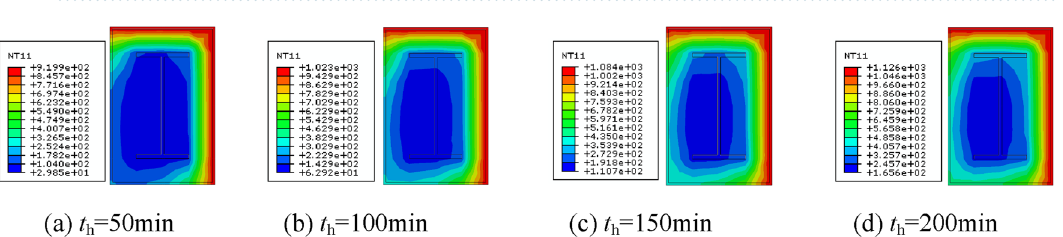
Figure 8. Cross-sectional temperature clouds at various stages of the fire on three surfaces.